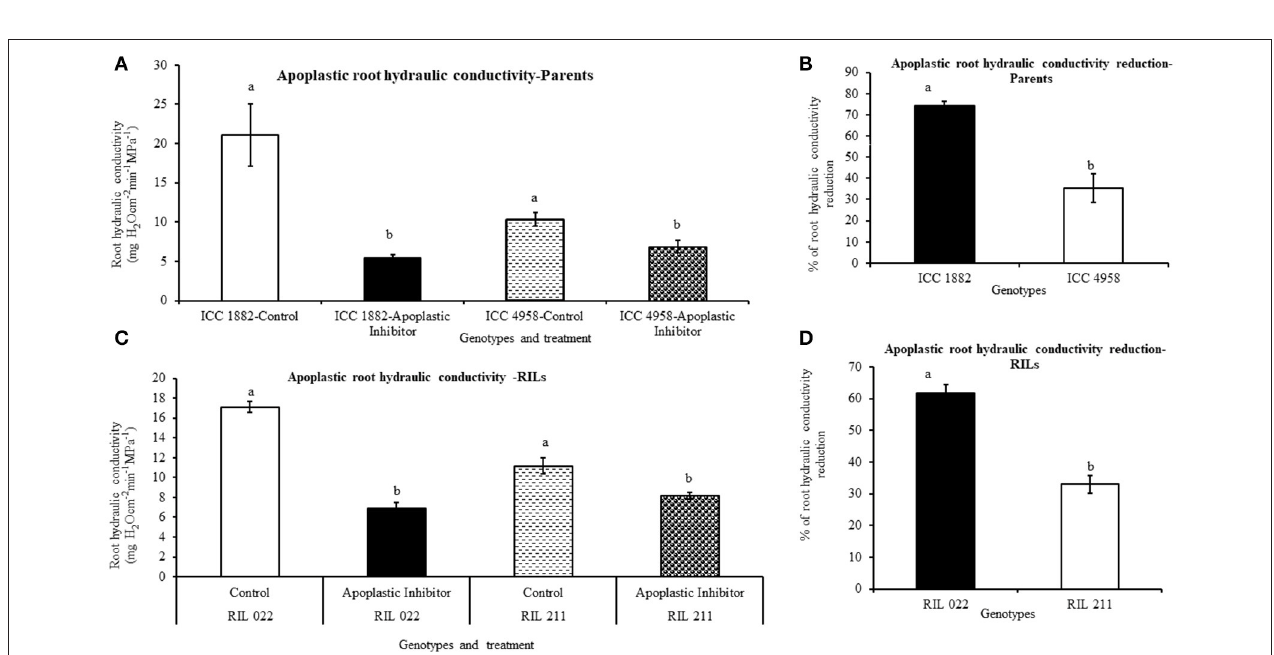
FIGURE 8 | Differences root hydraulic conductivity in de-topped plants of four chickpea genotypes after apoplastic inhibition [1 mM K 4 [Fe(CN) 6 ] and 0.25 mM CuSO 4 ]. Hydraulic conductivity under controlled and treated (inhibited) conditions were represents in graph (A,C) and also open bars represents ICC 1882 and RIL 022 and open bars filled with dashed lines represents ICC 4958 and RIL 211. The same graph (A,C) , closed bars represents ICC 1882 and RIL 022 and closed bars filled with dotted spot represents ICC 4958 and RIL 211. The graph (B,D) represents percentage of hydraulic conductivity reduction parents and progenies. Each bar data represents the root hydraulic conductivity means ( ± SE) of eight replicates per genotype. Bars with different letters are significantly different ( P = 0.05).